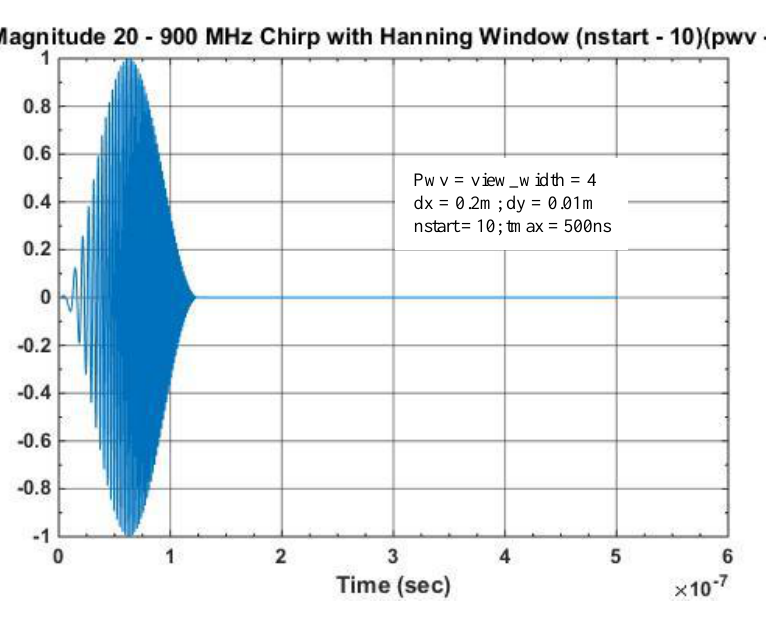
Figure 2. Computed chirp signal.